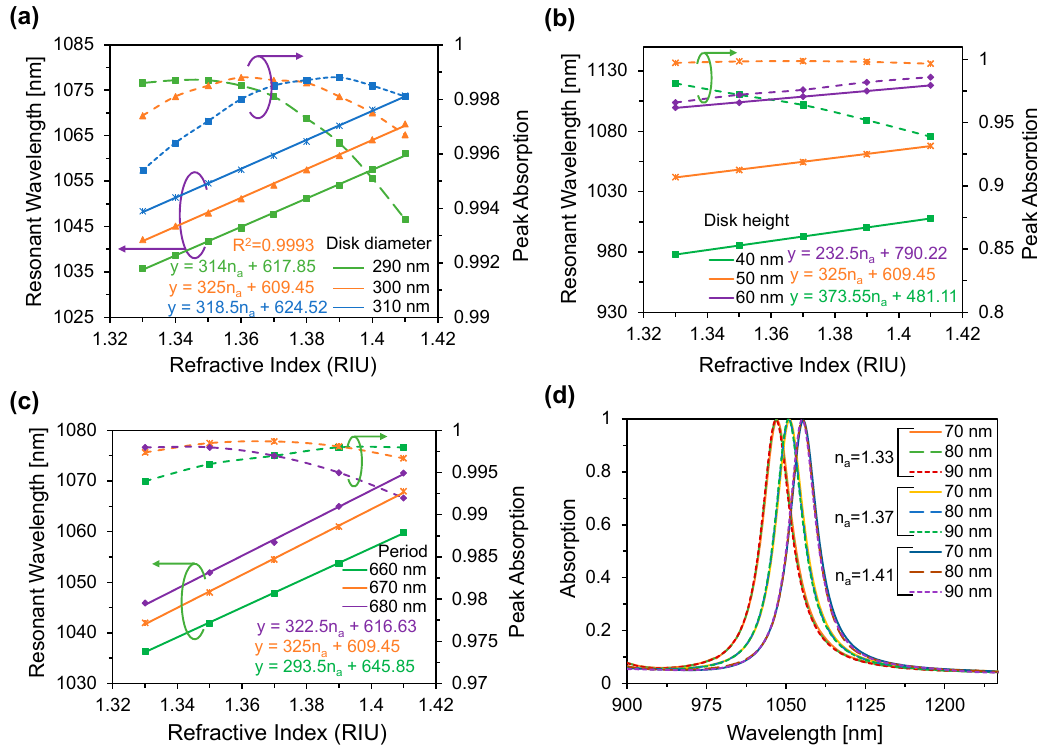
Figure 3. Resonant wavelength as a function of refractive index with varying the ( a ) disk diameter, ( b ) disk height and ( c ) period. ( d ) Absorption spectra with varying gold thickness and analyte RI. The center-to-center distance between the two adjacent disks corresponds to period. Its